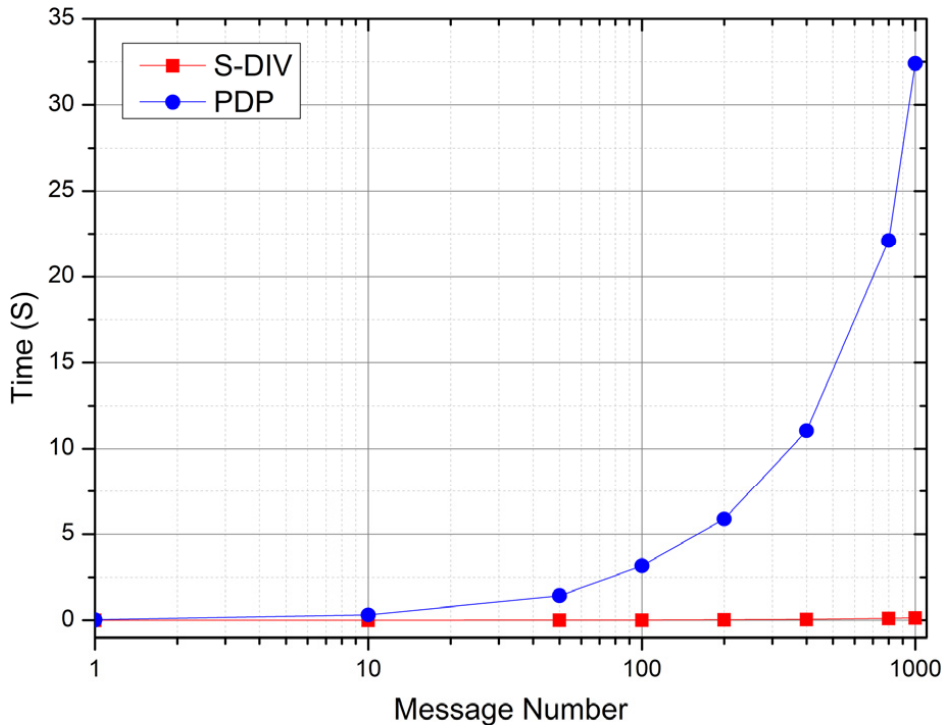
Figure 4. Comparison of preprocessing efficiency between S-DIV and PDP.